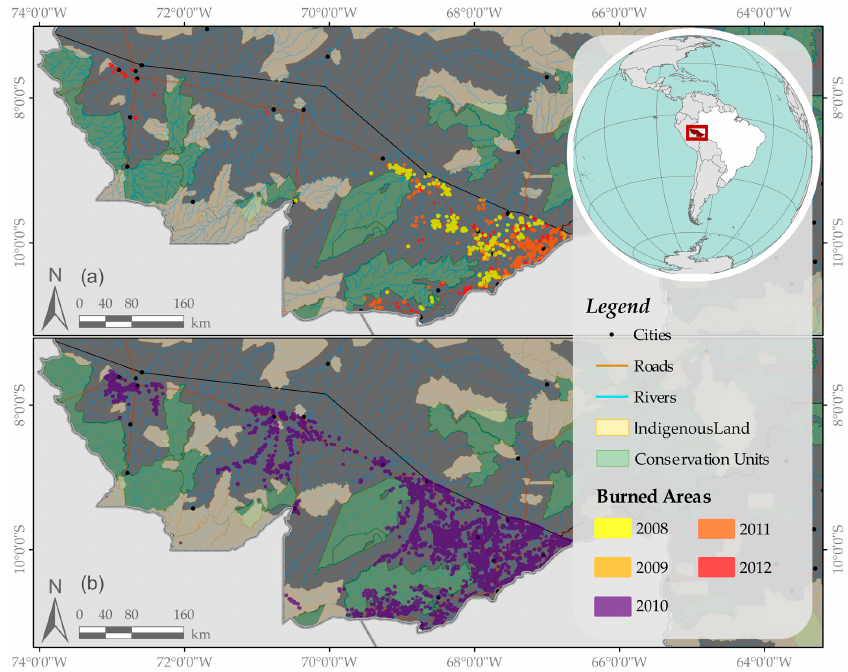
Figure 2. Burn scars in Acre state (Brazil), mapped with 250 m spatial resolution, for the regular climate years of 2008, 2009, 2011, and 2012 ( a ) and for the 2010 drought year ( b ). Every year new burn scars were mapped (Table A4). However, the number of polygons varied substantially (24–3521). Their size also had a large annual standard deviation (SD). The maximum SD reached 2.54 km² in 2010, while the minimum SD of 1.28 km² was recorded in 2011. In 2010 the highest number of polygons were observed (3521) and the largest total burned area (2056.8 km²) among all years analyzed was expressed, respectively, 19 times larger and 16 times higher than the mean of the other four years. The largest polygon observed in our time-series had more than 100 km², which occurred in 2010, while, in any other year the largest burned polygon had an area of 16.90 km². Considering that Acre´s dry season (months with monthly rainfall < 100 mm) in 2010 extended by one month, totaling four months in this year, the 3521 observed burn scars (2056.8 km²) corresponded to around 29 burning events per day in the dry season, with an average of 16.85 ±